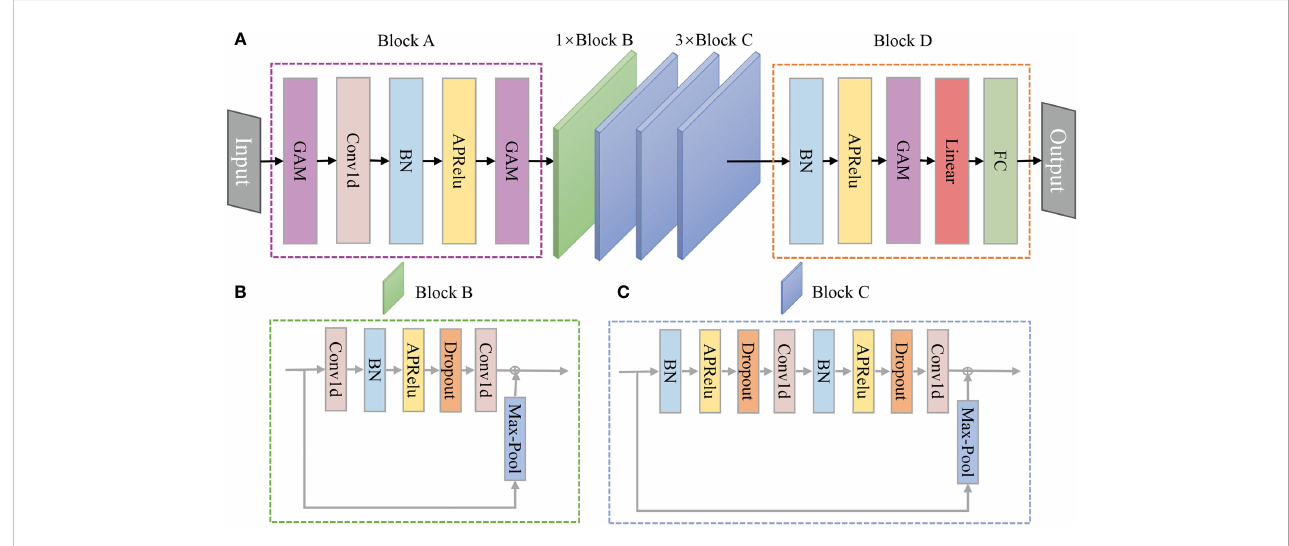
sequentially combines channel attention and spatial attention.